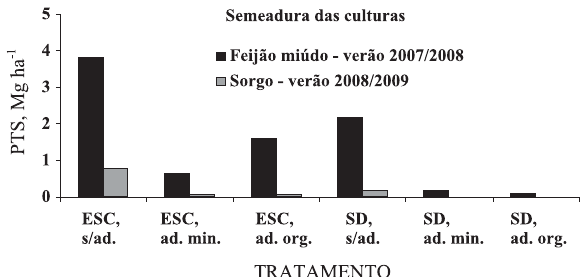
erosão realizados logo após a semeadura das culturas, nos tratamentos estudados (Obs.: não houve perda mensurável de solo nos testes de erosão realizados no estádio fenológico de enchimento de legumes do feijão-miúdo e no de maturação do